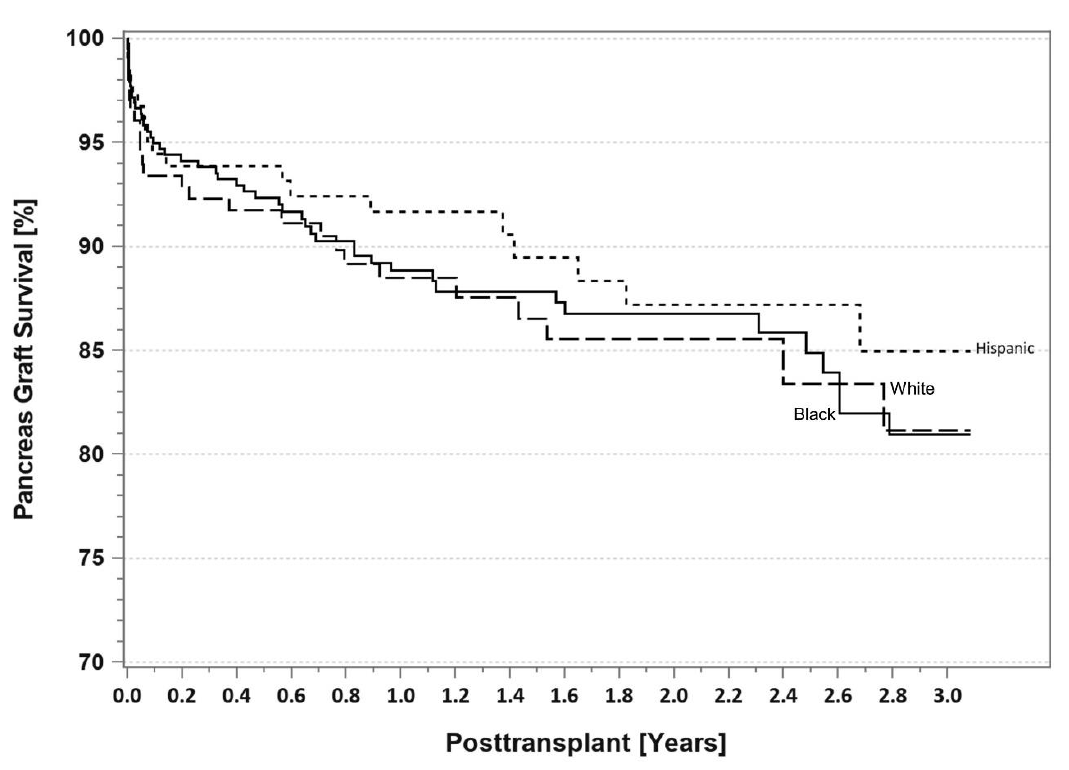
Figure 13. SPKT pancreas graft survival according to recipient race in patients identified as having